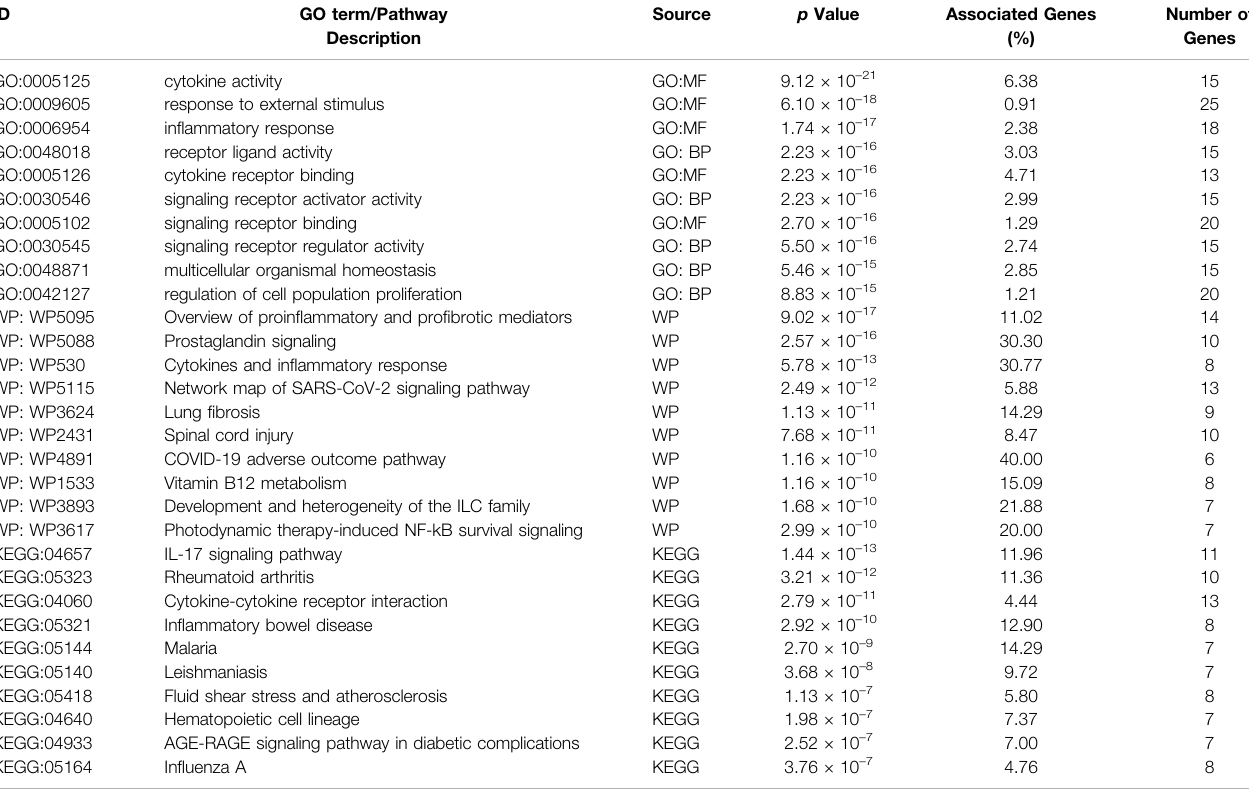
TABLE 2 | Enrichment analysis results of cluster 1 genes (Top 10 biological functions, WP pathways, and KEGG pathways). ID GO term/Pathway Description